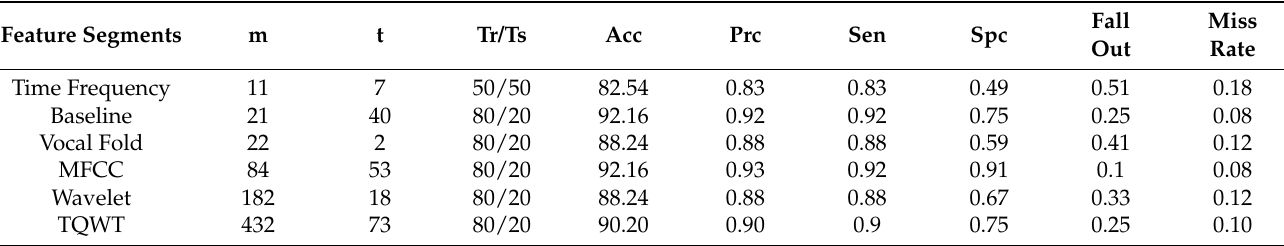
Table 5. Maximum performance received for SysFor classifier with minimum number of decision trees on primary and derived features of Istanbul acoustic dataset.